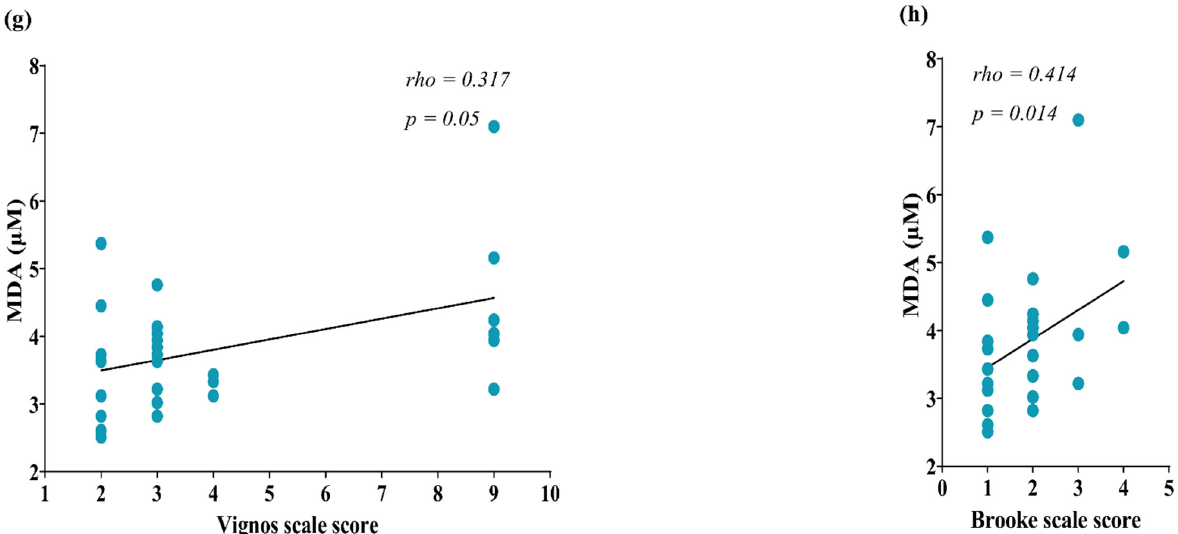
Figure 2. Correlation of circulating markers of OS with muscle injury parameters of DMD patients. ( a ) Nrf2 & GMFCS scale score; ( b ) Nrf2 & Vignos scale score; ( c ) NRF2 & GMFCS scale score; ( d ) Nrf2 & Brooke scale score; ( e ) Glutathione & Brooke scale score; ( f ) Glutathione & ALT; ( g ) MDA & Vignos scale score; ( h ) MDA & Brooke scale score. The correlation was computed by Spearman’s correlations (N = 28) for glutathione, N = 25. Data of Nrf2 concentration were transformed to Log 10 for a better data representation in the figures. OS, Oxidative stress; Nrf2, NFE2 like bZIP transcription factor 2; GMFCS, Gross Motor Function Classification System; MDA, Malondialdehyde.